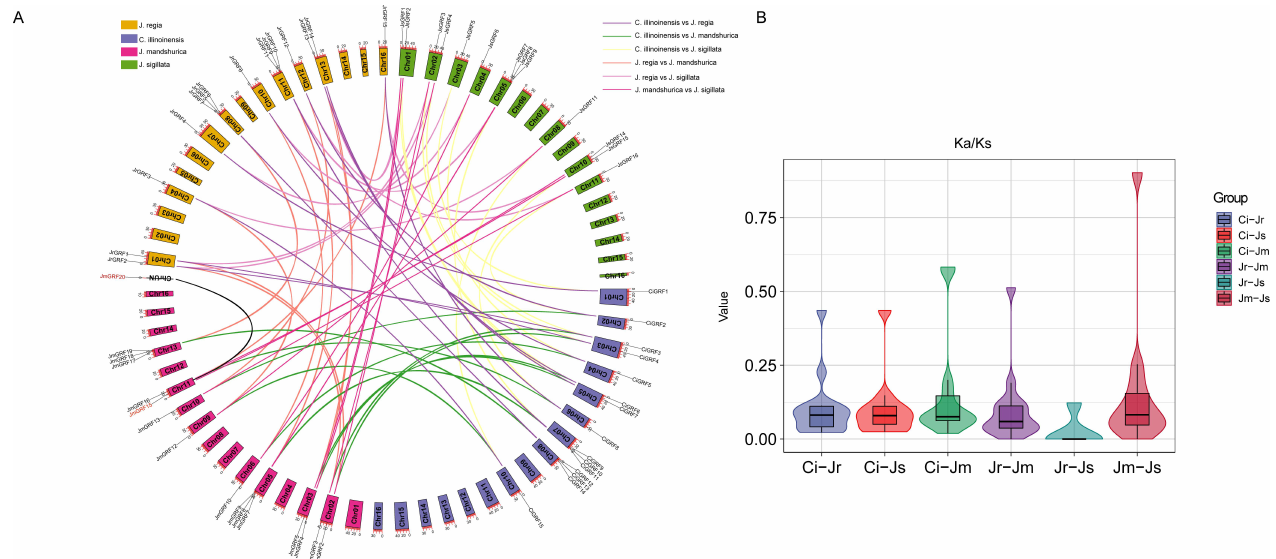
Figure 4. ( A ) Circle plot of paralogous and orthologous GRF gene pairs among the four Juglandaceae species. The number on the scale represents the physical location of each chromosome. ( B ) Ks and Ka/Ks values of orthologous GRF gene pairs between any two of the four Juglandaceae species.